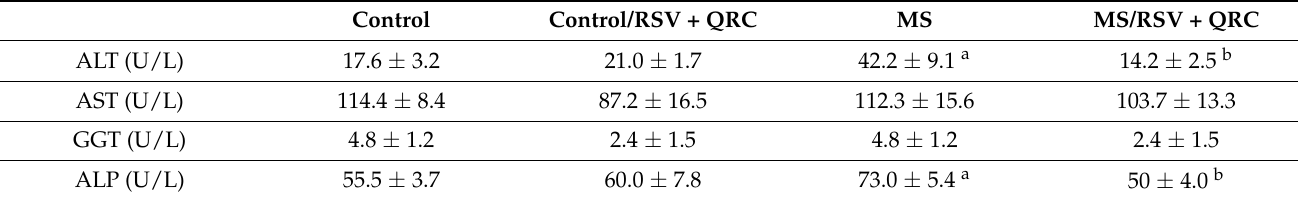
Figure 8. Effect of resveratrol and quercetin treatment on the expression of PPAR isotypes in the liver. Representative western blot from Control ( A ) and metabolic syndrome (MS) rats ( B ). ( C ) Expression of PPAR- α and PPAR- γ in Control group; ( D ) Expression of PPAR- α and PPAR- γ in MS group. Data represent mean ± SEM ( n = 6 per group). Table 2. Effects of polyphenols on liver function in experimental